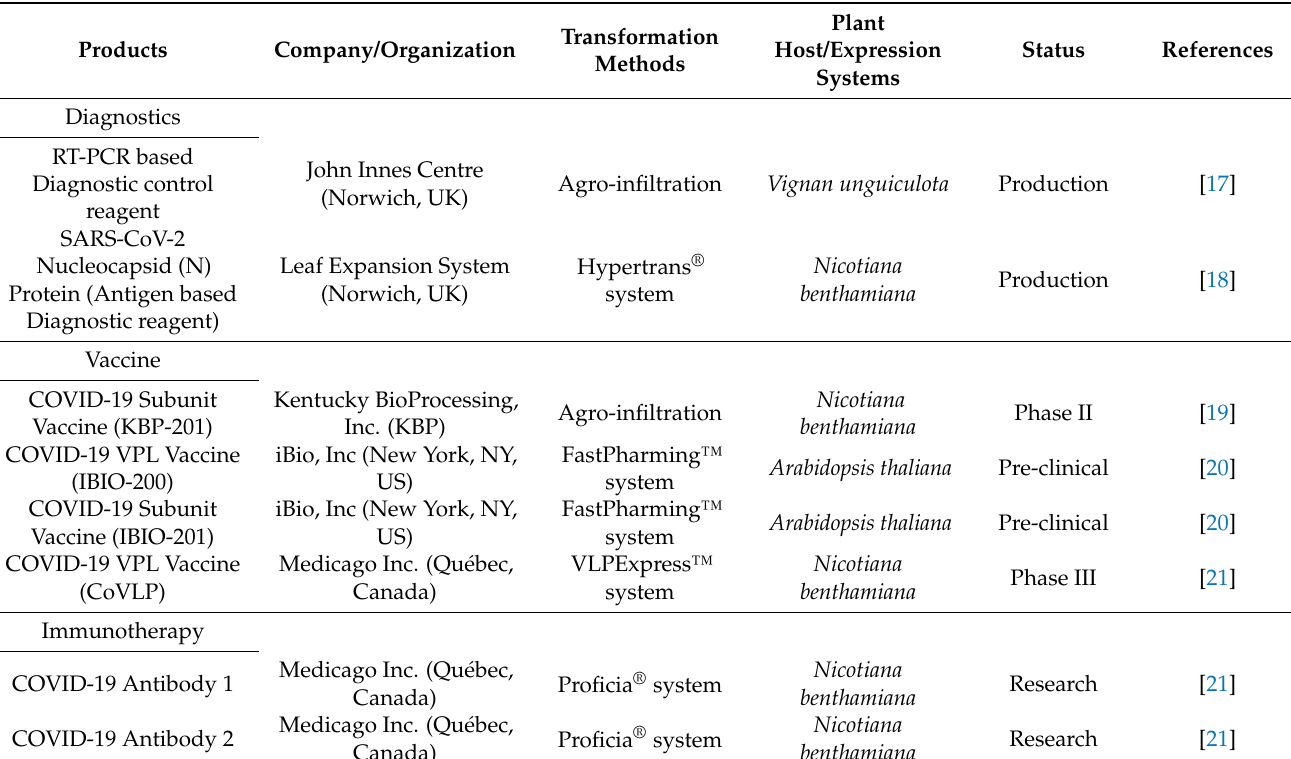
Table 1. Plant-based biopharmaceuticals under production to address the COVID-19 crisis.